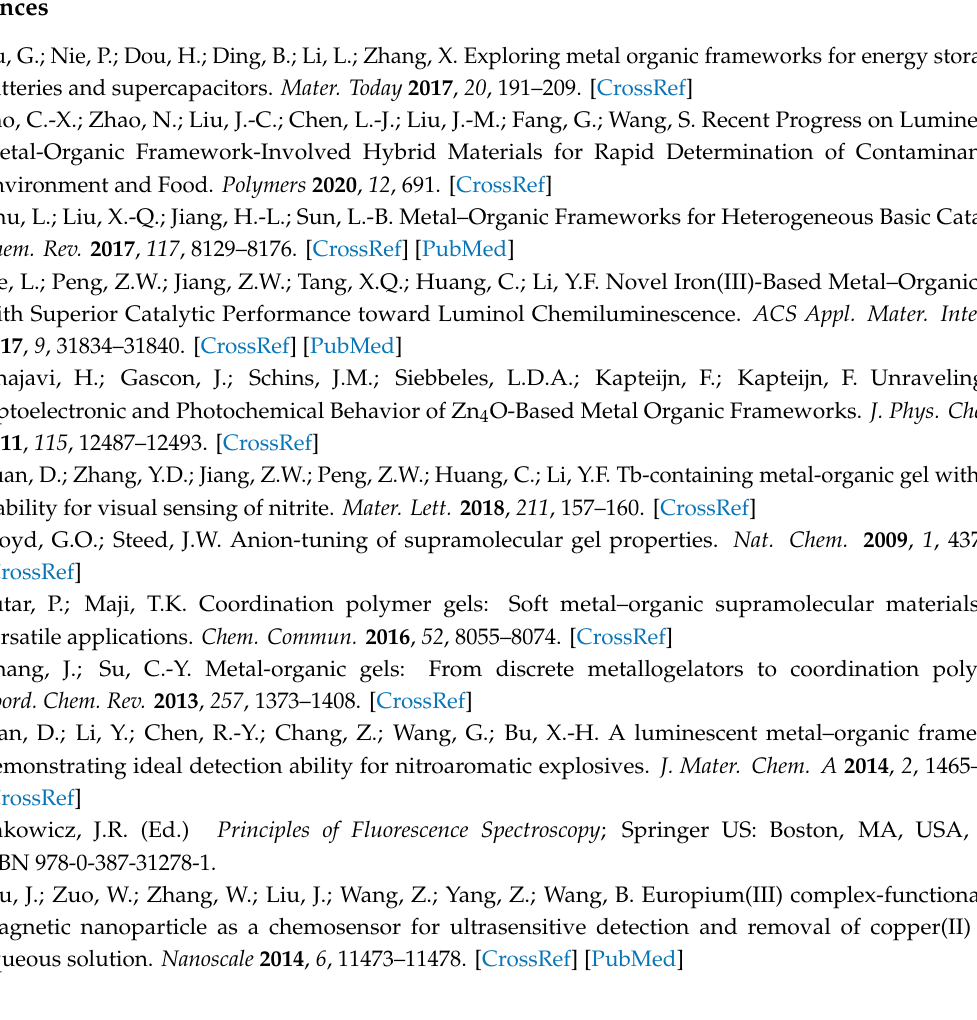
emission intensities of (A) Eu 3 + / PSA at 616 nm and (left) (B) Tb 3 + / PSA at 545 nm (right), without Cu 2 + (black) and with 3.33 mM of Cu 2 + (red), Figure S5: Emission spectra of Eu 3 + / PSA, 5 D 0 → 7 F 2 transition emission intensity at 616 nm (inset) of Eu 3 + / PSA with di ff erent concentrations of Cu 2 + , T S6: Emission spectra of Eu 3 + / PSA and Stern-Volmer plot of 5 D 0 → 7 F 2 transition at 616 nm (inset) for Eu 3 + / PSA with lower concentrations of Cu 2 + , Figure S7: Emission spectra of Tb 3 + / PSA and 5 D 4 → 7 F 5 transition intensities at 545 nm (inset) for Tb 3 + / PSA with di ff erent concentrations of Cu 2 + , Figure S8: Emission spectra of Tb 3 + / PSA and Stern-Volmer plot of 5 D 4 → 7 F 5 transition at 545 nm (inset) for Tb 3 + / PSA with lower concentrations of Cu 2 + , SEM micrographs of (a) Eu 3 + / PSA, (b)Tb 3 + / PSA before contact with Cu 2 + and (c) Eu 3 + / PSA, (d) Tb 3 + / PSA after contact with Cu 2 + . Magnification × 500, Figure S10: (a) SEM micrography, (b) EDX spectra and elemental maps of Tb 3 + / PSA after contact with Cu 2 +